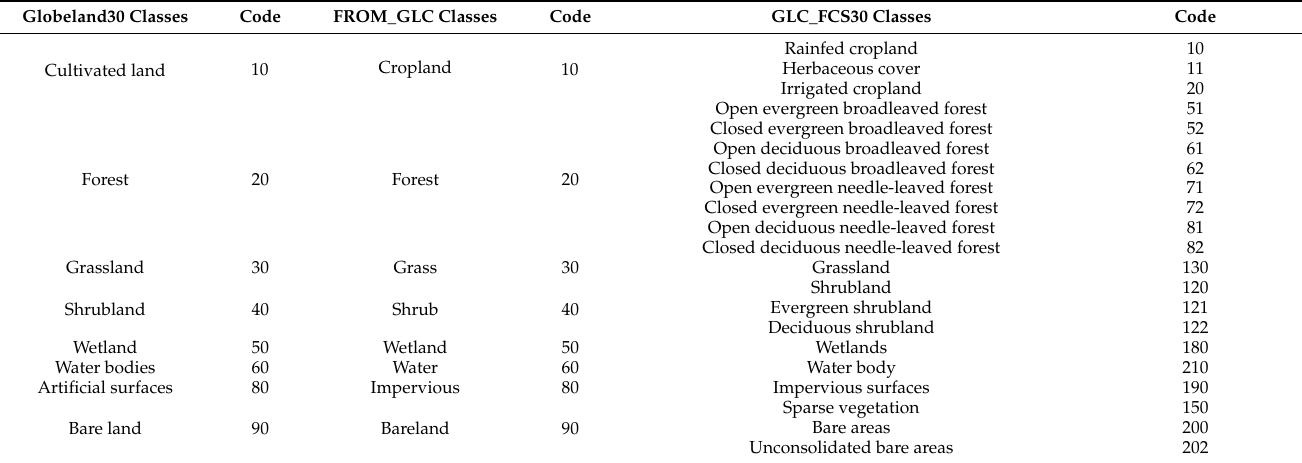
Table 1. Relating base products’ classification systems. Column “Code” in the table is the integer defined to encode class labels in the LC products